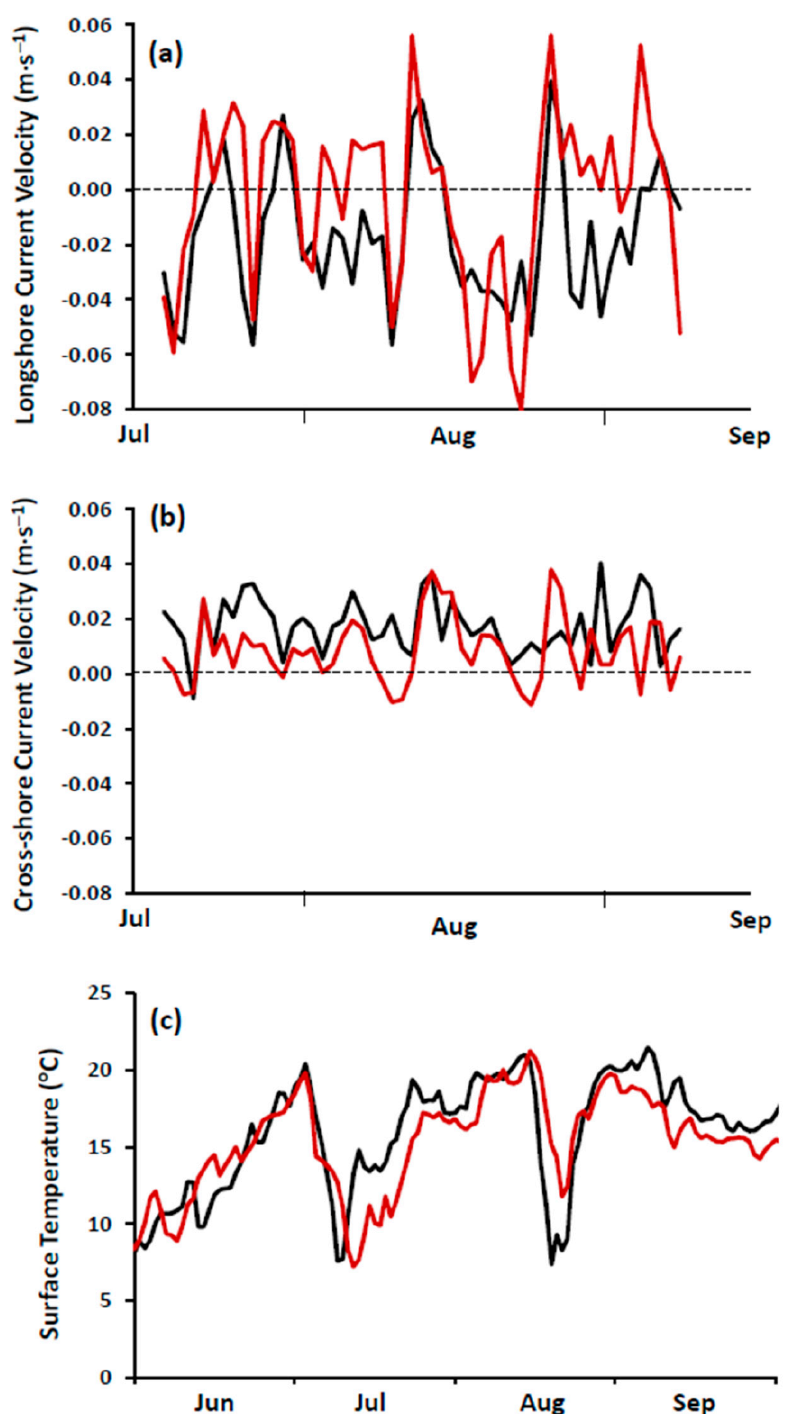
Figure 4. Performance testing of the hydrodynamic model (FVCOM): ( a ) daily averaged longshore current velocity at 5 m; positive values are W → E and negative values E → W, ( b ) cross-shore current; positive values are onshore, N, and negative values are offshore, S and ( c ) surface temperature measured at National Data Buoy Center (NDBC) Buoy 45159 (Supplementary Material, Figure